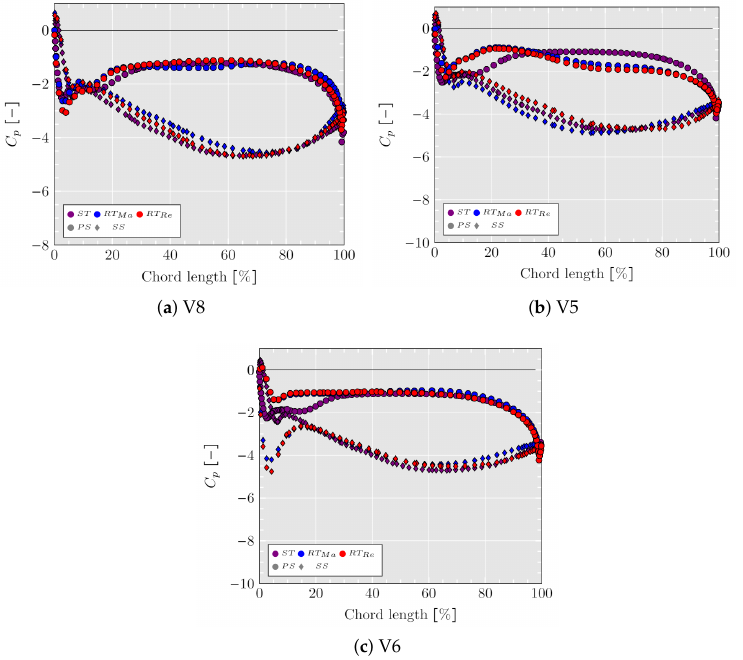
Figure 7. C p for each studied vane. ST & RT. VGT60. 0.5 mm tip height. In figure legends color stands for each case while shapes in grey determines each one of the vane faces.